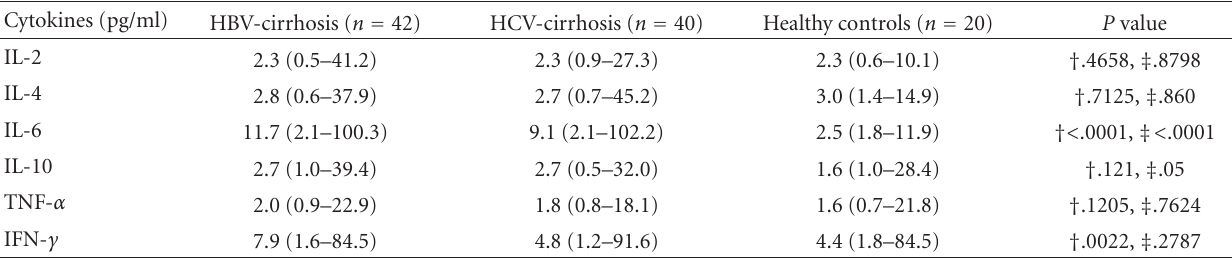
Table 2: T-Lymphocyte cytokine subsets of healthy and cirrhosis